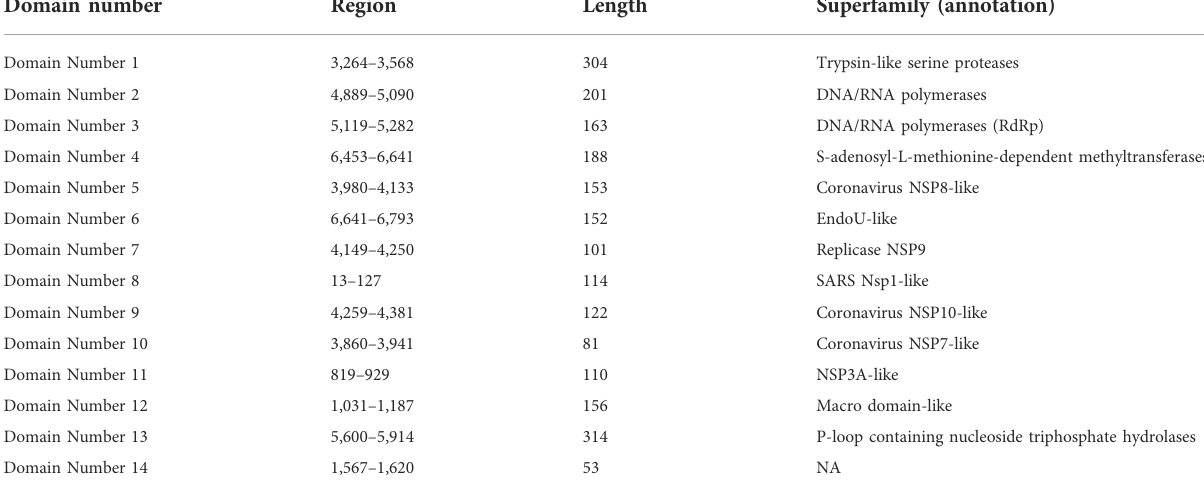
TABLE 2 Table representing the 14 domains of orf1ab sequence (QIB84672.1) which is assigned by Superfamily database. Domain number